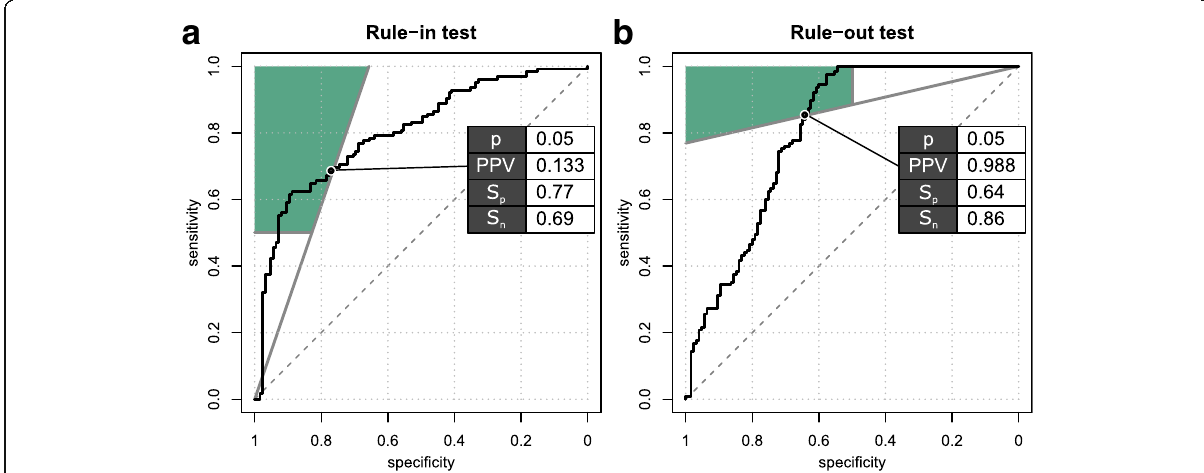
Fig. 5 Multivariable modelling . Two possible prognostic test permutations for pre-eclampsia prediction in first-time pregnant women are shown (hypothetical data) ( a ). Rule-in test compliant with pre-set test specification: PPV ≥ 0.133, S n ≥ 0.50, for a 5% disease prevalence. b Rule-out test compliant with pre-set test specification: NPV ≥ 0.988, S p ≥ 0.50, for a 5% disease